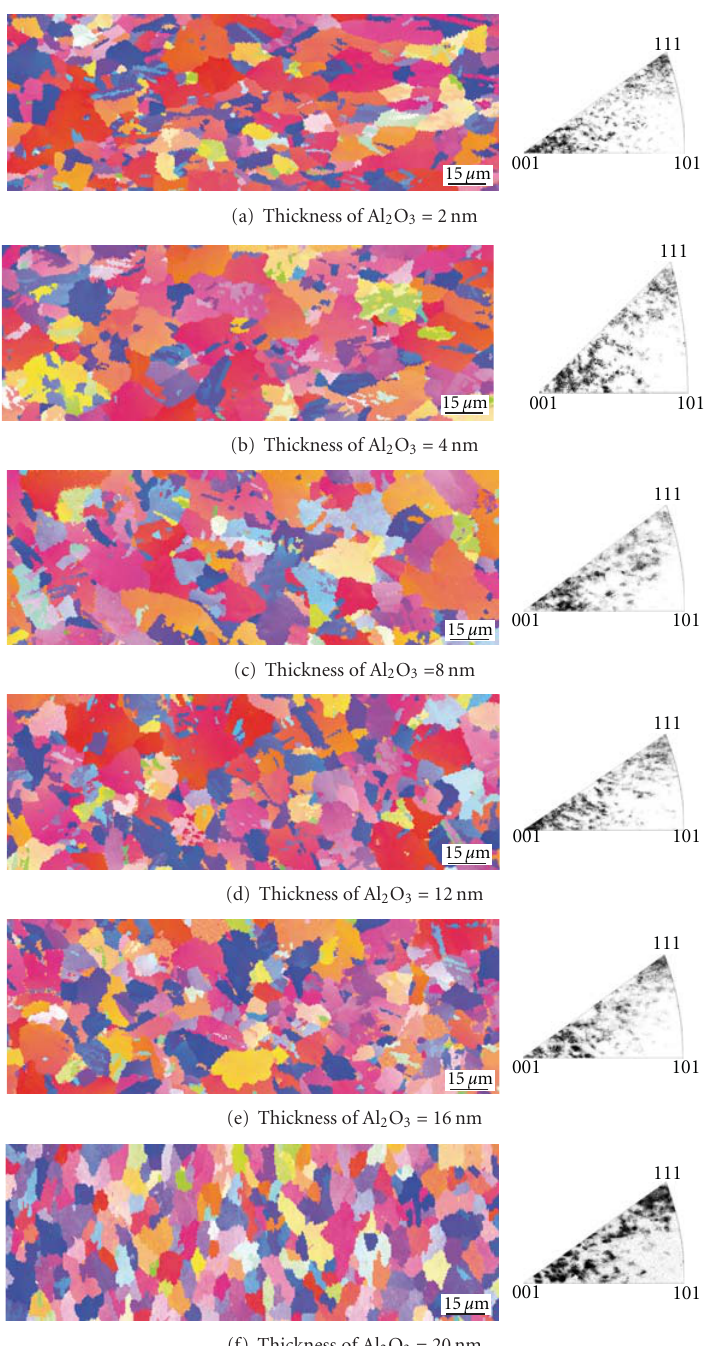
Figure 6: EBSD orientation maps and inverse pole figures of the polysilicon films in normal direction related to various Al oxide thicknesses.